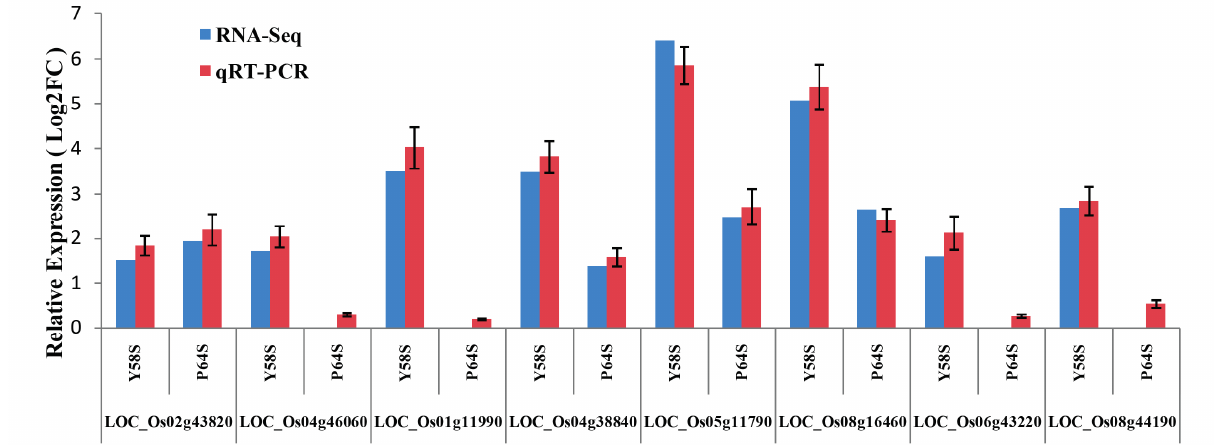
Figure 4. Comparison of genes expression levels using RNA-Seq and qRT-PCR. The relative expression values were normalized to the rice actin 1 gene. Error bars indicate standard deviation. Log2FC refers to the log2 fold